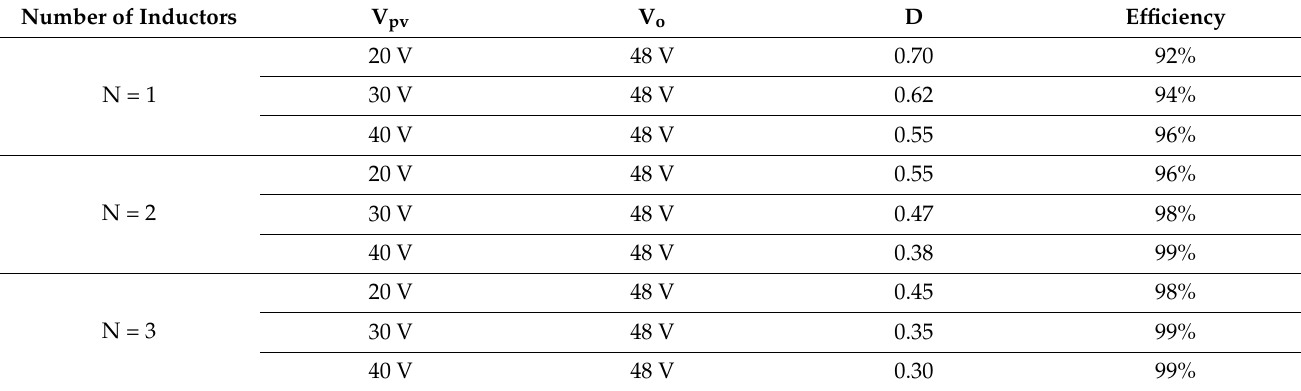
Table 4. Hardware results for the proposed IIABB converter for battery charger